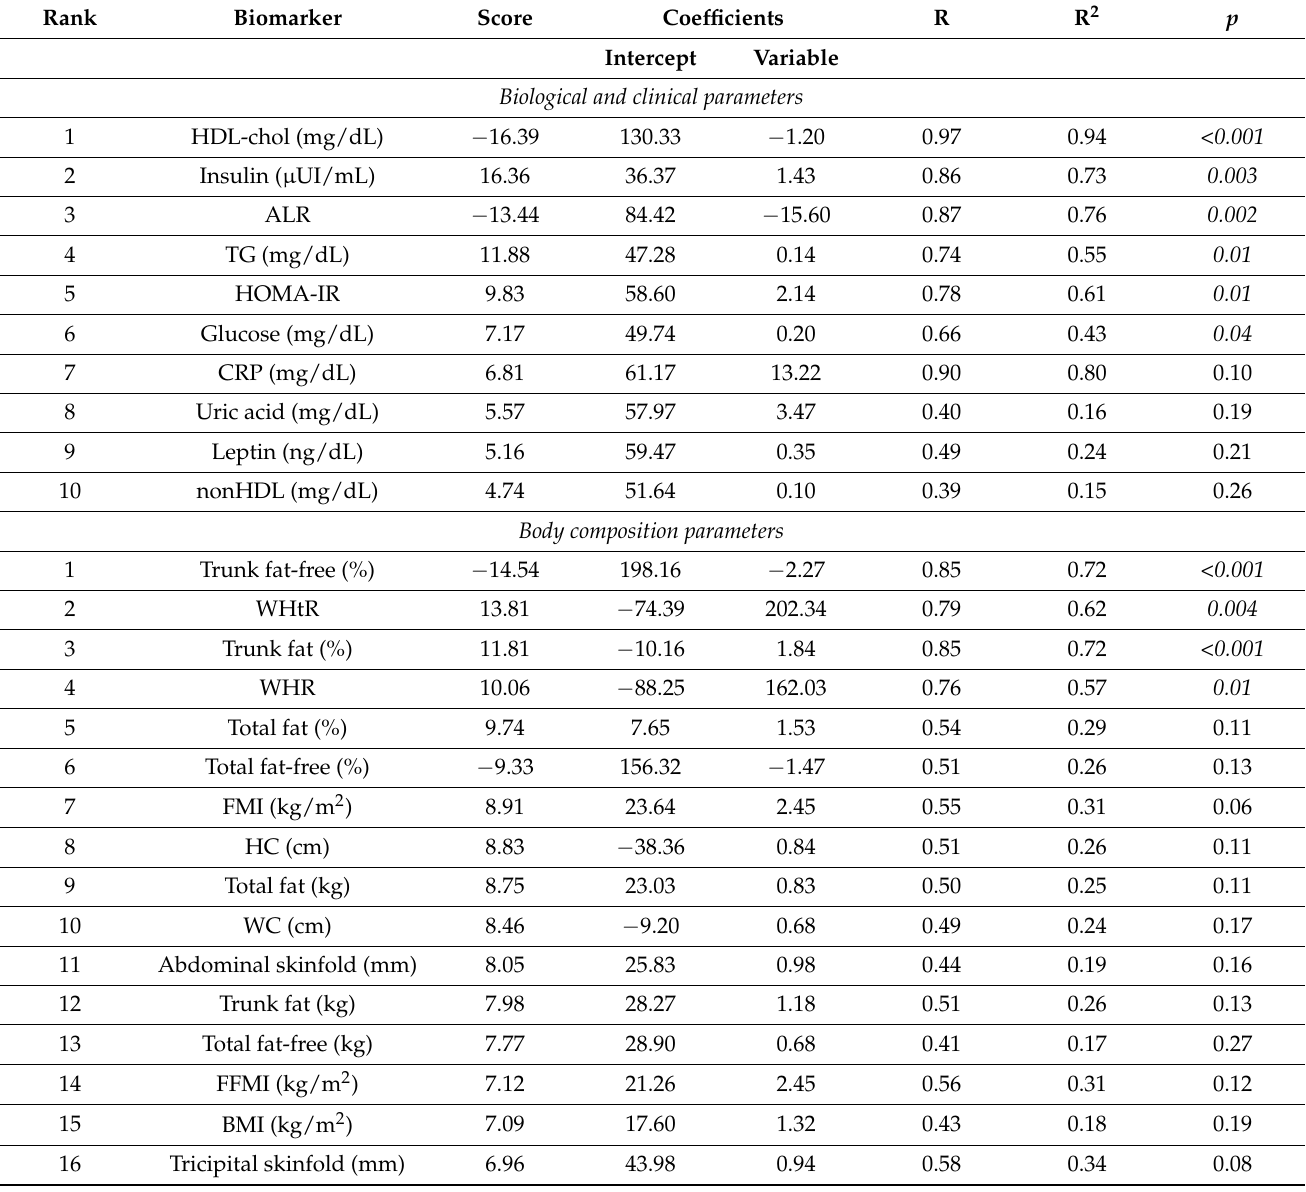
Table 3. Hierarchical order of biomarkers relevant for MetS